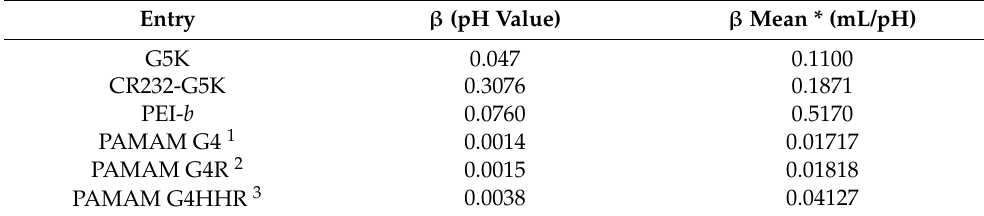
Table 4. Max. β values (pH range 6–7) and values of the β mean (pH range 4.5–7.5) of G5K and CR232-G5K compared with data of commercial PEI- b and of three PAMAM derivatives. Entry β (pH